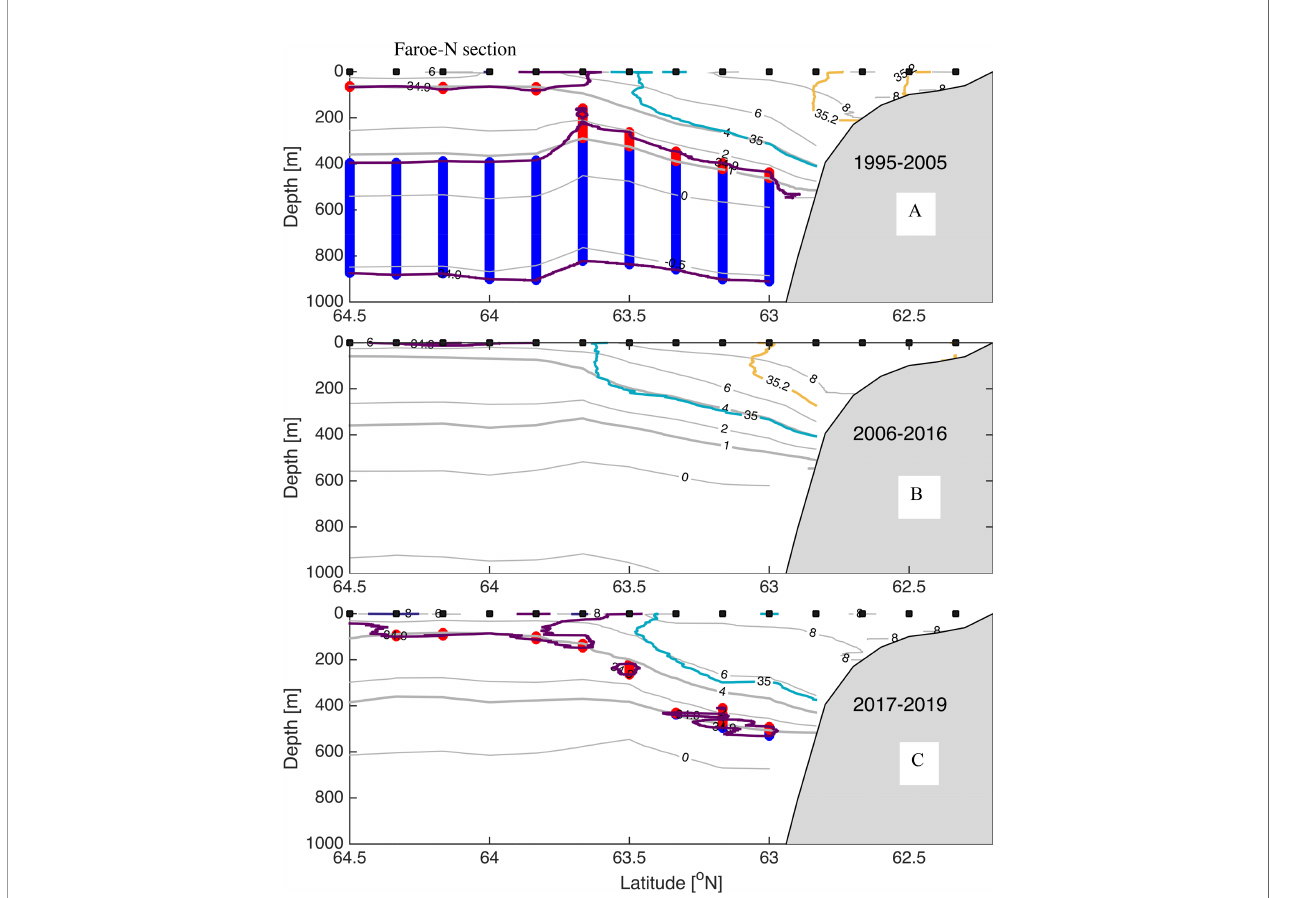
Water (blue) and Modi fi ed East Icelandic Water (red). Black squares show positions of the